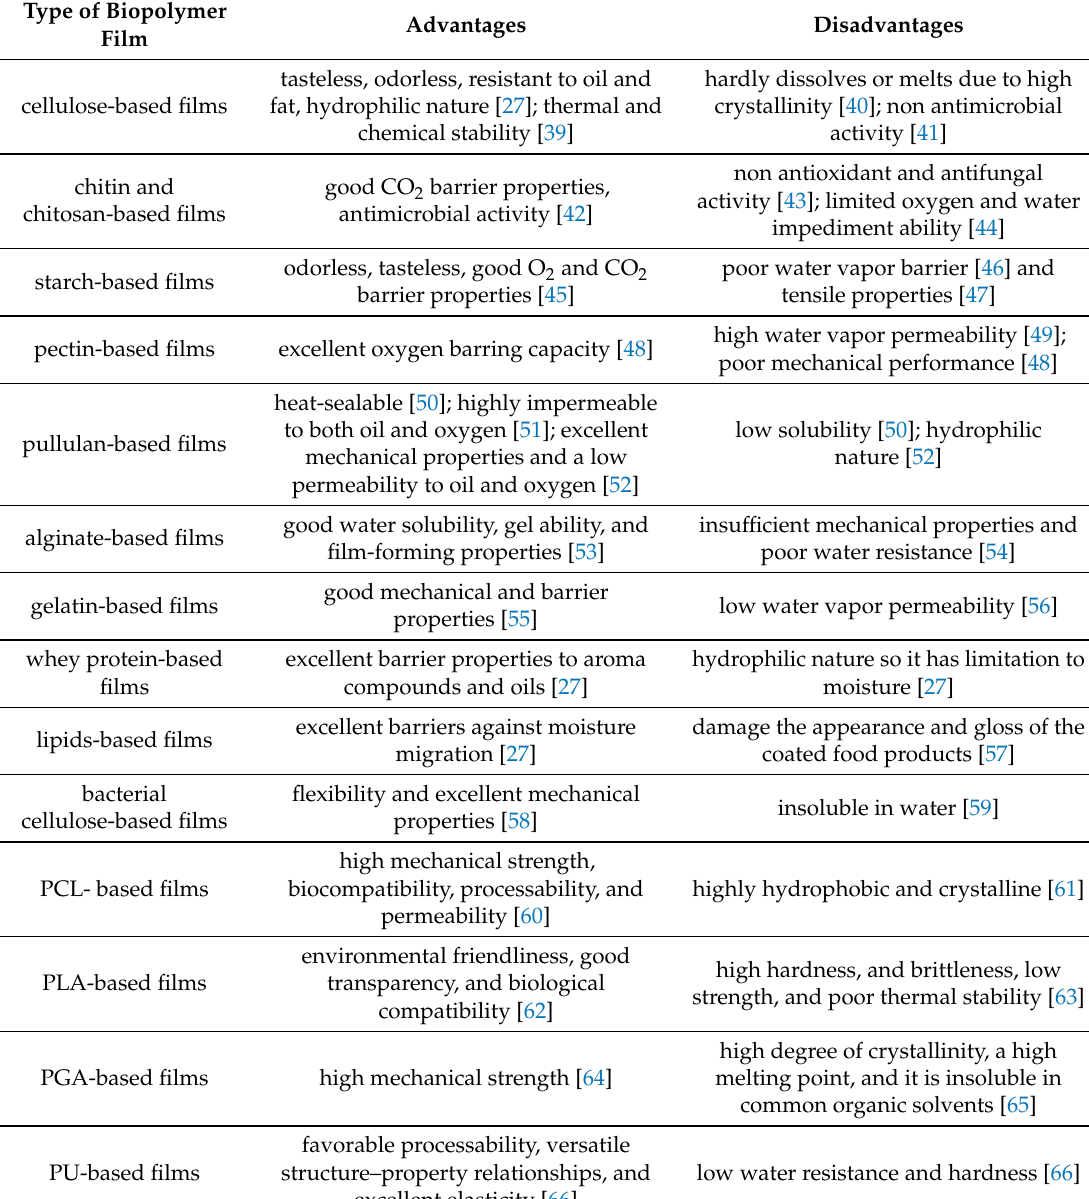
Table 1. Advantages and disadvantages of biopolymer